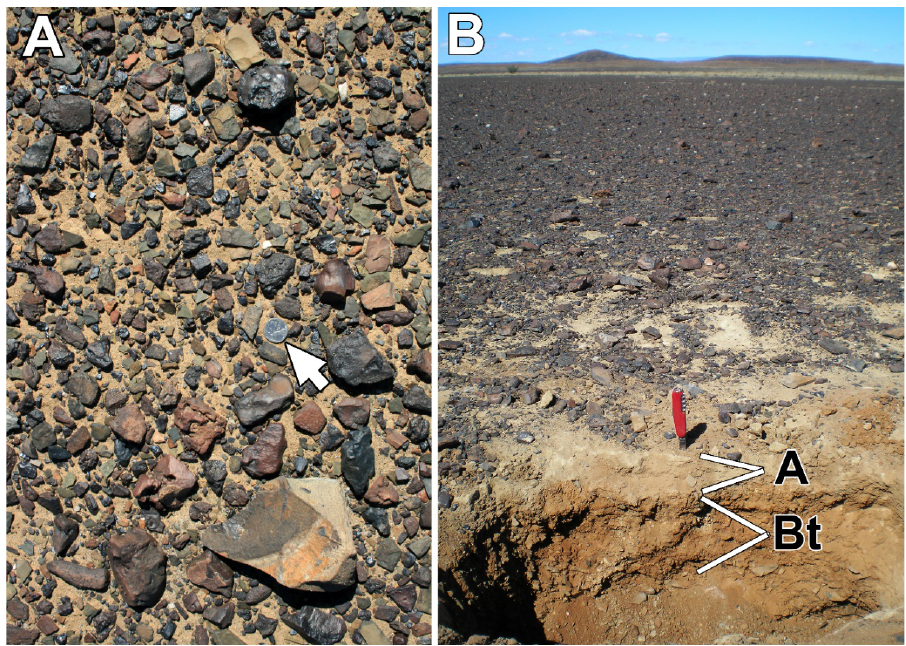
Figure 8. ( A ) Surface of the Tankwa Karoo stone pavement, approximately three-quarters of which is covered by coarse gravels and pebbles. The white arrow points to a 20 mm diameter coin. ( B ) View of exposed soil profile showing light-coloured, essentially clast-free vesicular A horizon (5 cm thick) and underlying, strongly-reddened Bt horizon. The red handle of the pocket knife is 9 cm long. Profile description in Table 2.